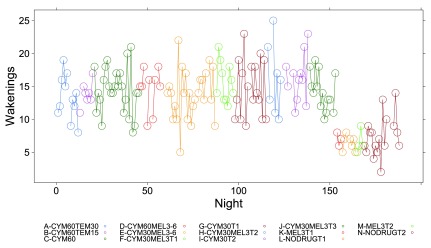
Wakenings per night.The number of times per night subject was awake during 5-minute intervals detected by the Zeo Sleep Monitor throughout the entire study. Dosages of Cymbalta (CYM60 = 60 mg, CYM30 = 30 mg), temazepam (TEM30 = 30 mg, TEM15 = 15 mg) and melatonin (MEL3 = 3 mg, MEL6 = 6 mg) were varied according to combinations A-N (T1, T2, T3 are trial replicates), including no drug trials (L, N).